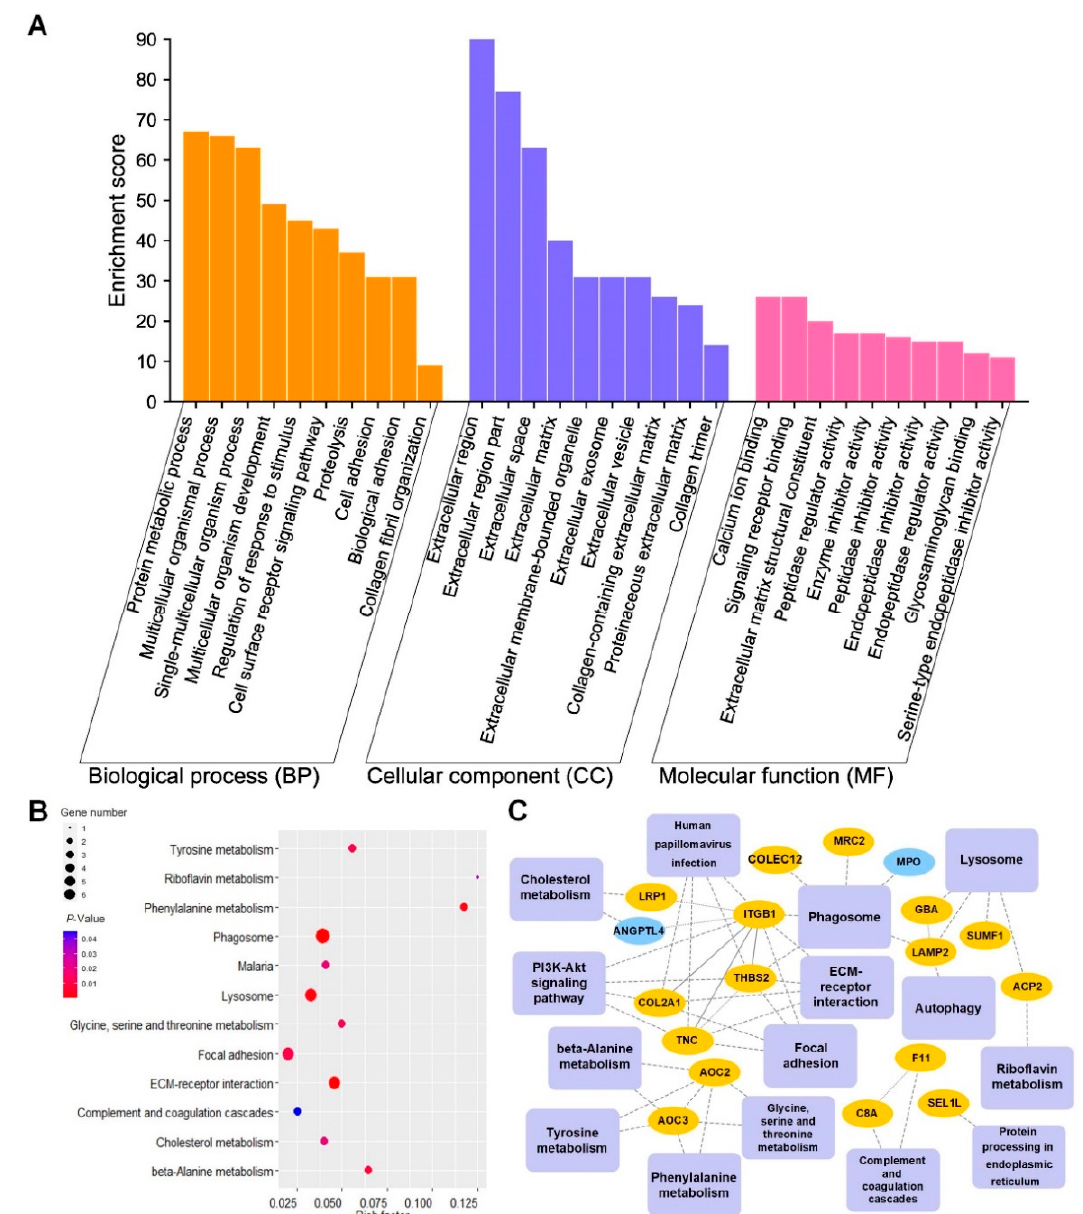
Figure 5. GO, KEGG pathway, and PPI analysis results of differentially expressed N-glycoproteins in OA vs. N. ( A ) GO analysis results of the differentially expressed N-glycoproteins of cartilage in OA vs. N. ( B ) Bubble diagram of KEGG pathways in OA vs. N. The blue to red gradient of bubbles of KEGG pathways represent the significance from low to high, respectively. Bubble size represents the number of differentially expressed N-glycoproteins in the KEGG pathway. ( C ) PPI network of the significantly differential N-glycoproteins and pathways in OA vs. N. Rectangles represent KEGG pathways, and circles represent N-glycoproteins. Solid lines mean the relationship has been verified by research, dashed lines mean the relationship have not been verified. The yellow and blue colors of the N-glycoproteins represent up-regulated and down-regulated, respectively.